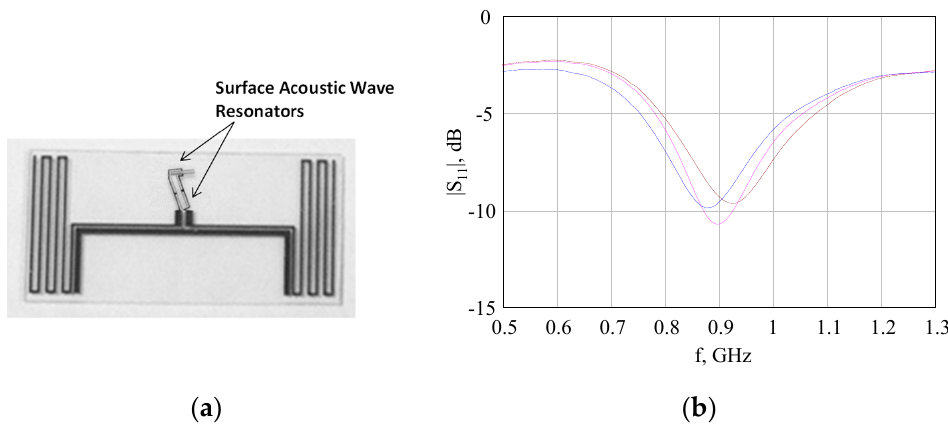
Figure 5. ( a ) The design of the implanted dipole loaded by SAW resonator; ( b )return loss measured for three test samples of the implanted dipole in the tissue-equivalent liquid.